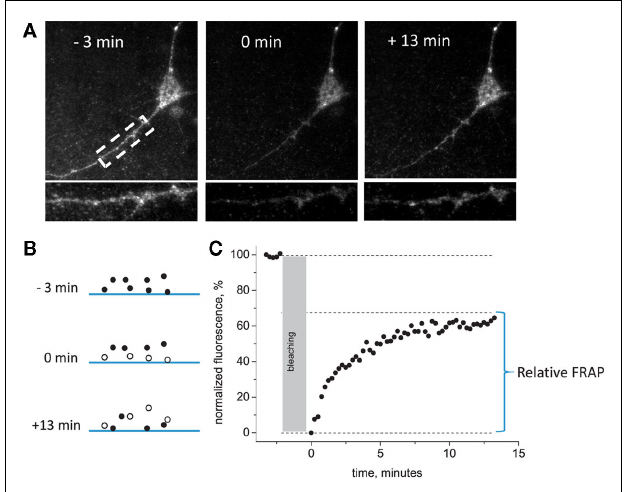
FIGURE 2 | General scheme ofTIRF – FRAP experiments. (A) Representative images of the hippocampal neuron expressing P2X3-DsRed acquired 3min before, 0min after, and 13min after the photobleaching at room temperature. An enlarged segment of the dendrite of the same neuron is presented in the lower panel. (B) A scheme illustrating fluorophore bleaching by the evanescent field. Only those fluorescently tagged receptors that are located in the close vicinity of the plasma membrane are bleached during prolongedTIRF illumination. (C) A typical plot of normalized fluorescence recovery after bleaching in the evanescent field. Pre-bleaching fluorescence = 100%, post-bleaching fluorescence = 0%. Relative FRAP is measured as the steady-state level to which the fluorescence recovers.